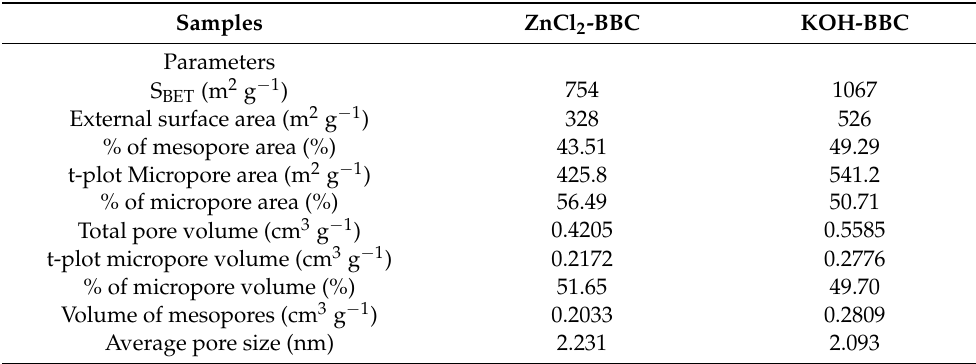
Figure 3. N 2 isotherm curves for ZnCl 2 -BBC and KOH-BBC ( A ) and pore distribution curves ( B ). Table 2. Textural properties of the activated